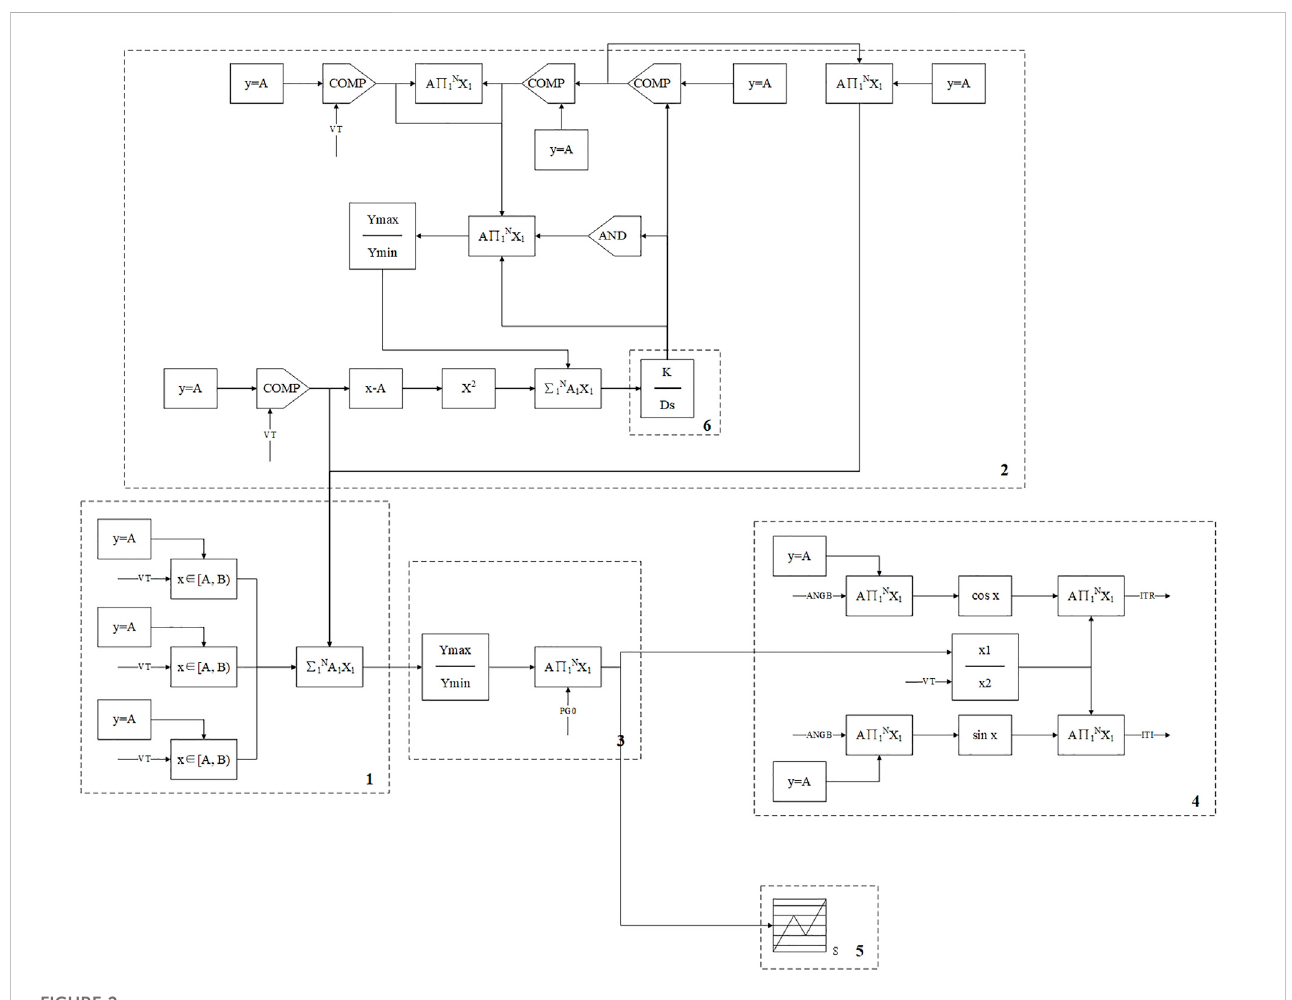
FIGURE 2 Logic block diagram of UD